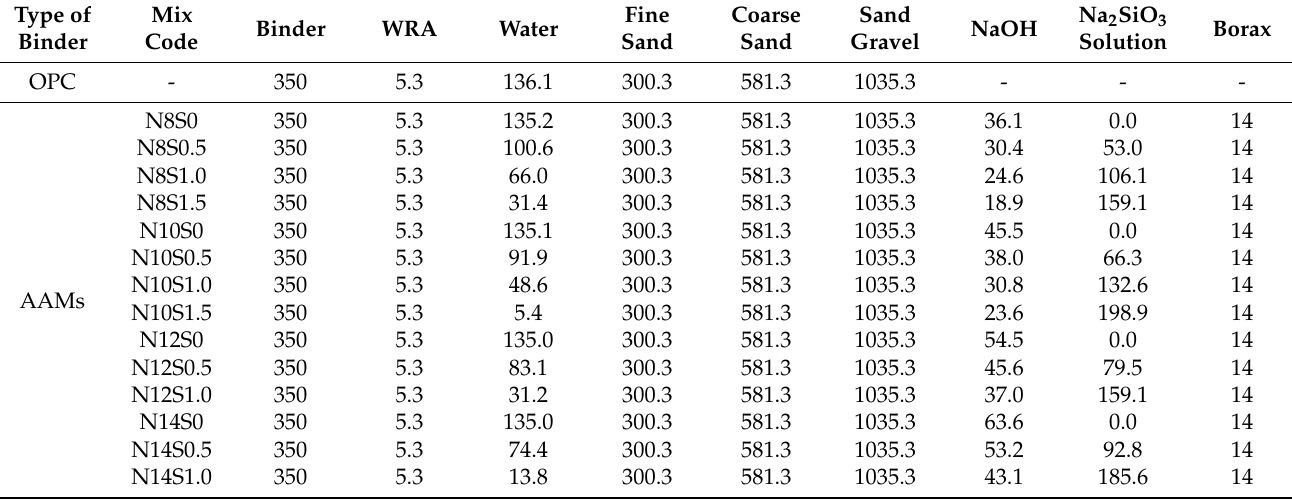
Table 2. Mix composition for all